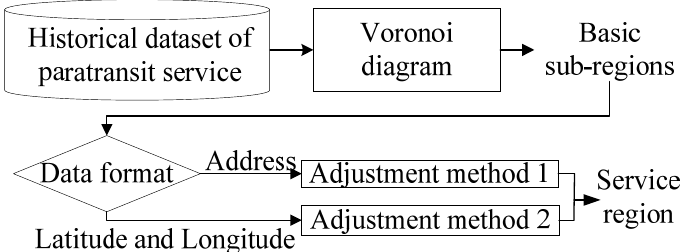
Figure 7. Flowchart of service region division.